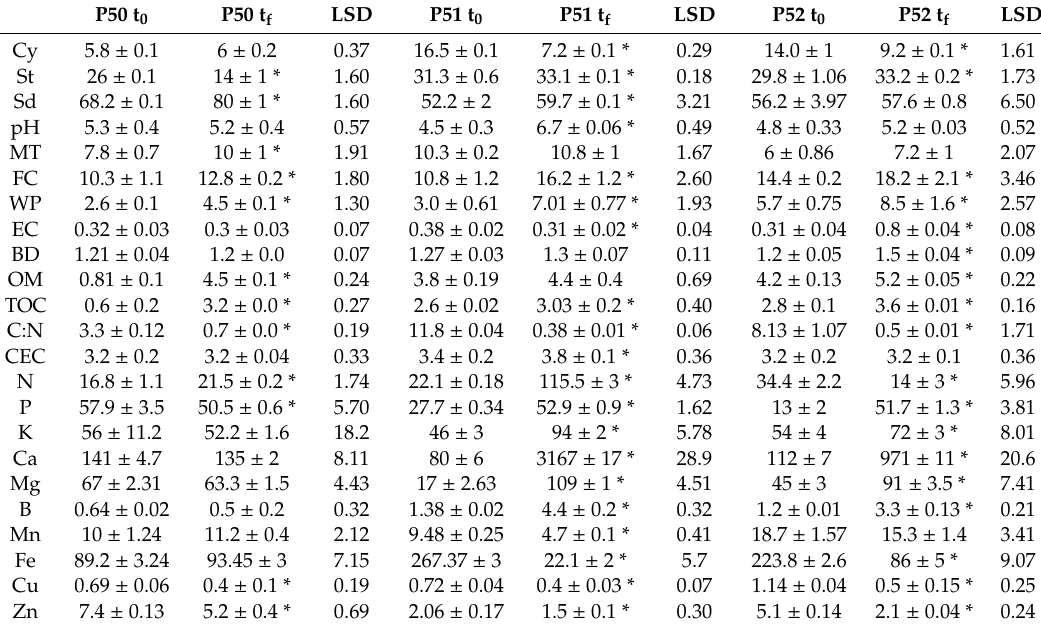
Table 2. Soils amendment comparative features at study